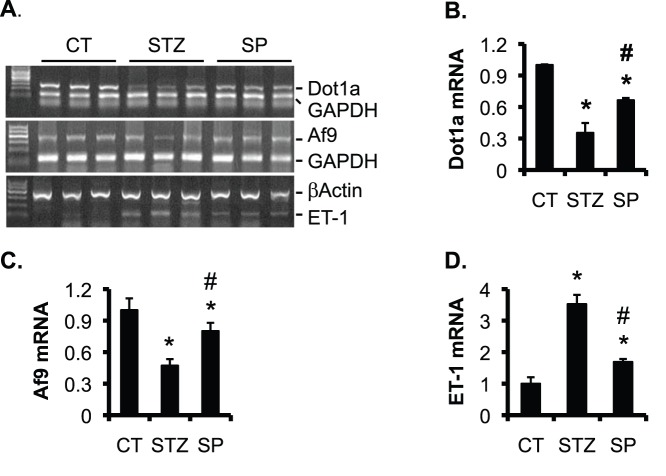
Spironolactone partially normalizes mRNA expression of Dot1a, Af9, and ET-1 in STZ-induced diabetic rats. (A)As in Fig. 1, representative agarose gel analyses of RT-PCR for expression of genes as indicated in the cortex of rats. (B–D) For each mRNA as indicated, the intensity of each corresponding band was quantified using ImageJ64, normalized to that of GAPDH or β-actin as shown in A, averaged within each group, and plotted, with the relative intensity in control (CT) set to 1. n = 8 rats/group. *P<0.05 vs. CT. #P<0.05 vs. STZ.